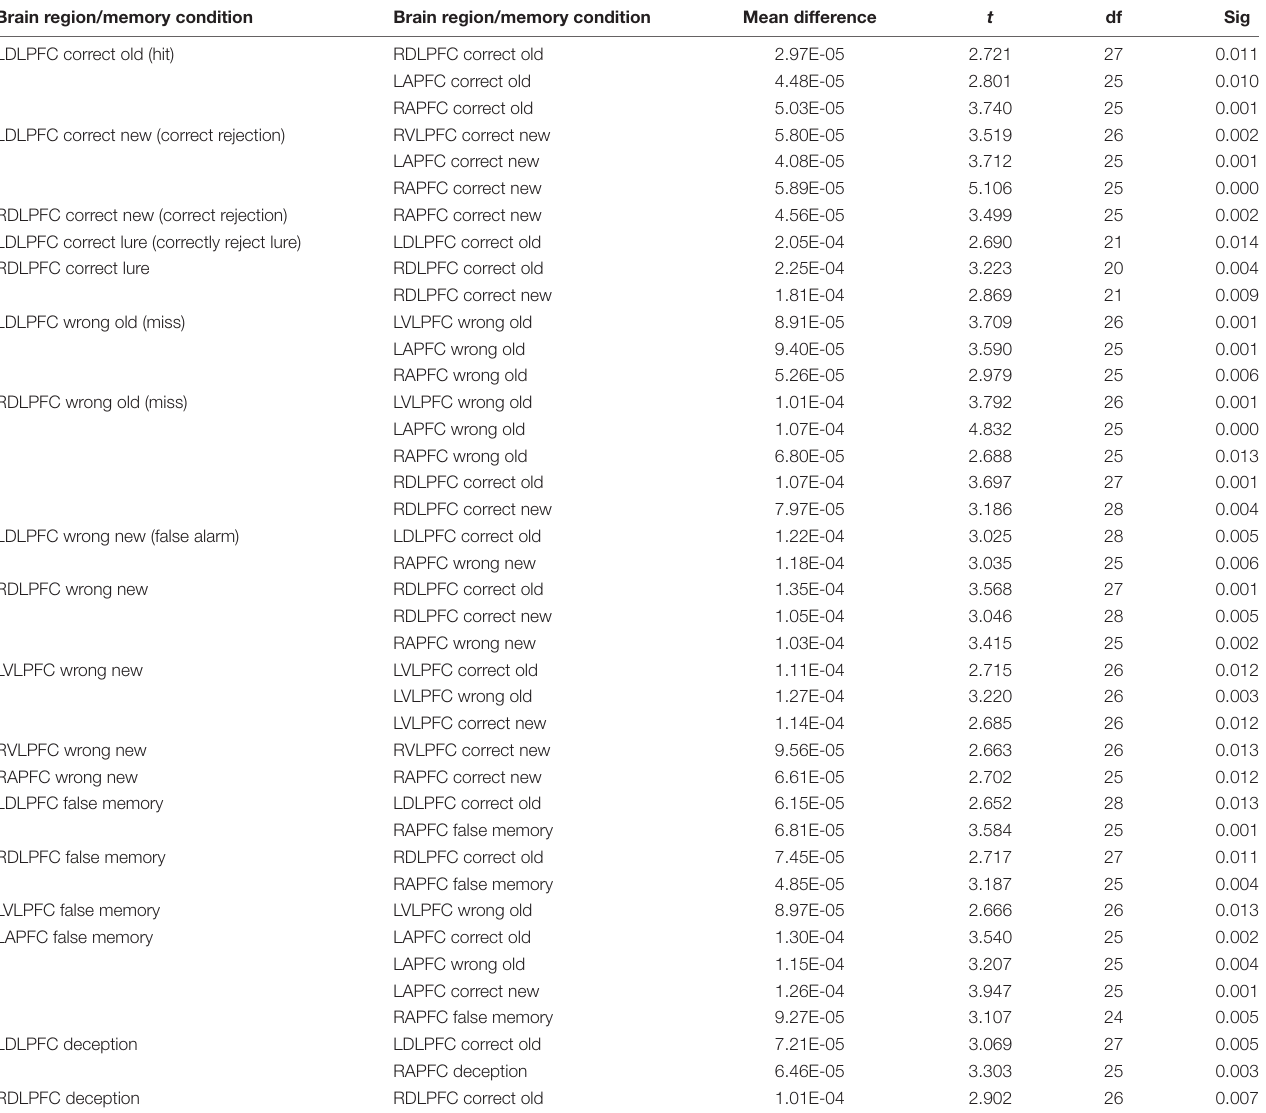
TABLE 3 | Significant differences ( p ≤ 0.01) between memory conditions in specific prefrontal regions. Brain region/memory condition Brain region/memory condition Mean